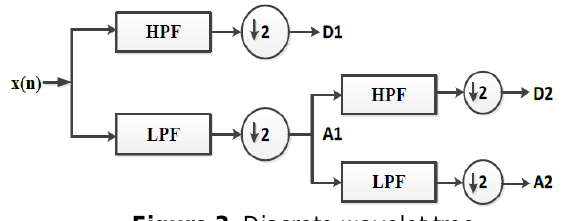
Figure 3. Discrete wavelet tree DWT Fault